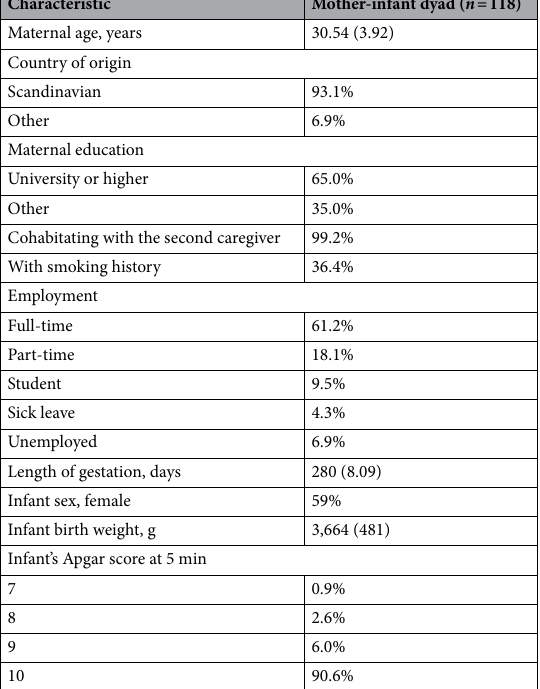
Table 3. Demographic characteristics of 118 mother-infant dyads. Data are given as the proportion of dyads or mean